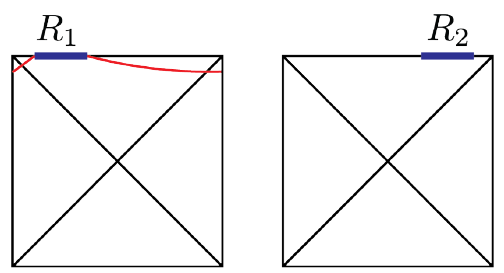
Figure 6. The true saddle for the problem of two regions near I + is actually two disconnected universes, with each region in its own copy of the original